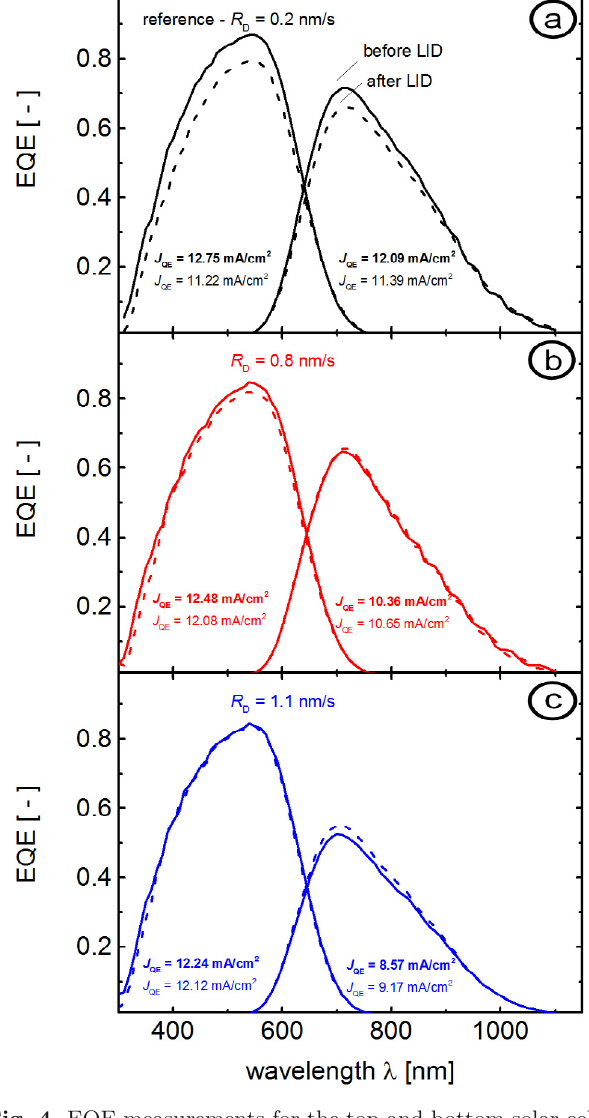
Fig. 4. EQE measurements for the top and bottom solar cells of sample 1 (a), sample 2 (b), and sample 3